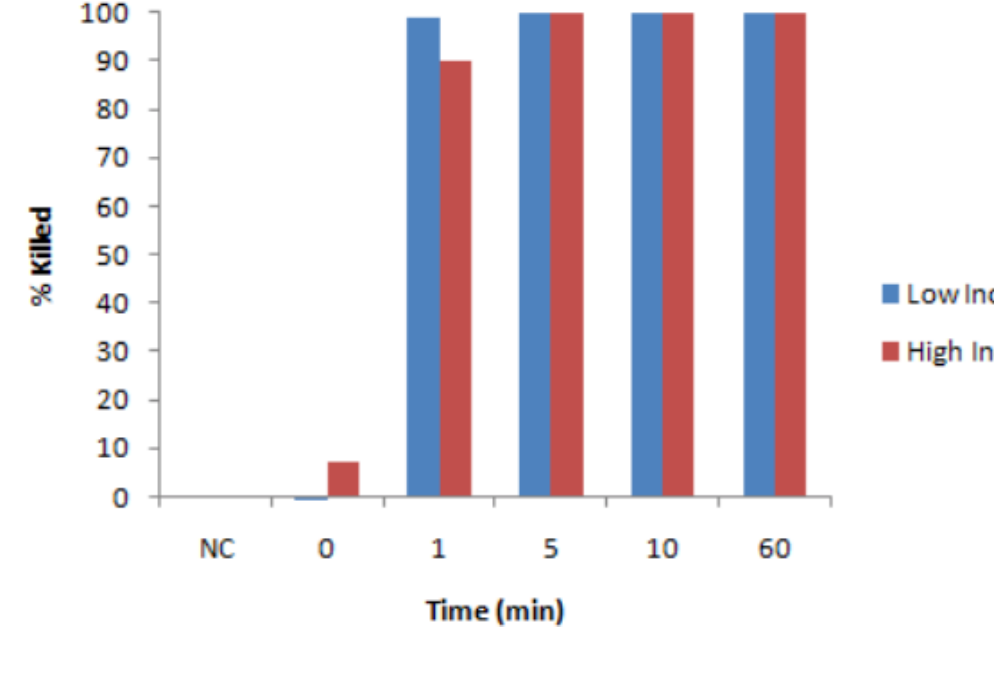
Figure 1. Antibacterial effect of CLO: Variation in bacterial number. Reaction mixtures (100 µL) contained either 1,500 cfu or 150,000 cfu of B. subtilis in saline with 1% CLO. At various times reactions were stopped by pelleting the bacteria in Eppendorf tubes, and the latter were washed in saline and assayed for cfu. Blue bars: low inoculum; red bars: high inoculum. % kill in comparison with unexposed controls. NC, untreated